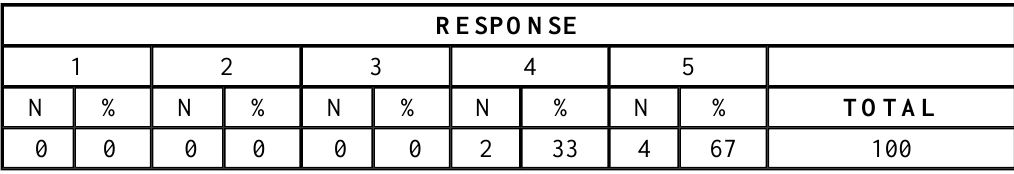
Table 2 Understanding of the concept of business intelligence